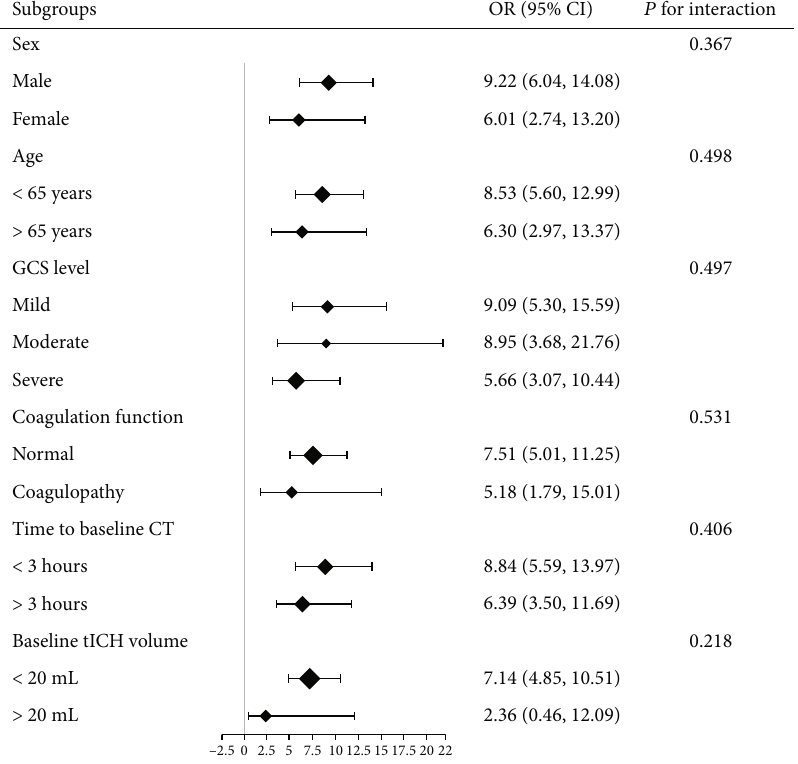
Figure 2: OR (95% CI) for acute tICH expansion in subgroups of cerebral contusion patients and interaction test of the strati fi cation variables and